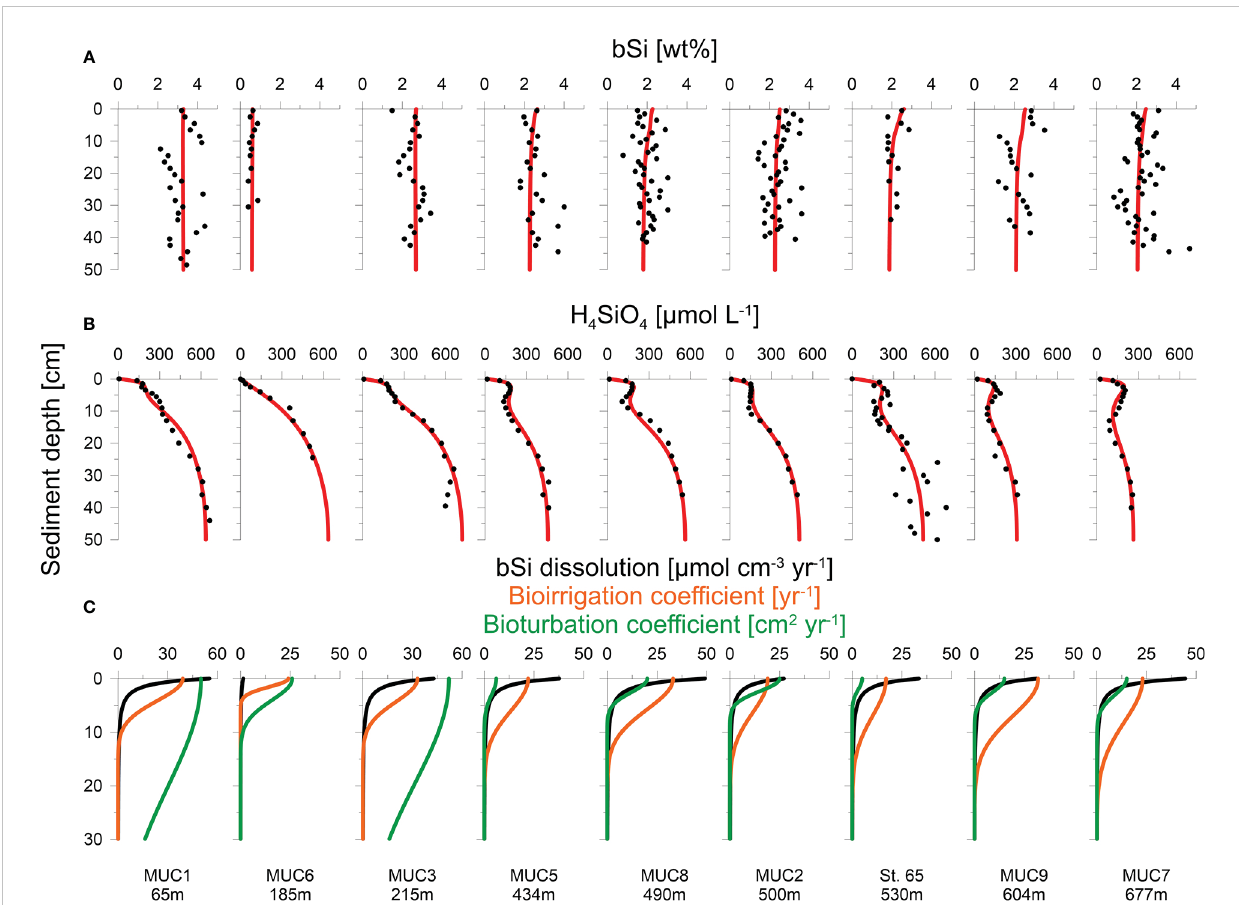
FIGURE 3 Measured data (symbols) and model simulations (curves) of (A) H 4 SiO 4 concentration, (B) bSi content and (C) net bSi dissolution rates (black), bioirrigation coef fi cient (orange) and bioturbation (green). Note different depth scale in (C)